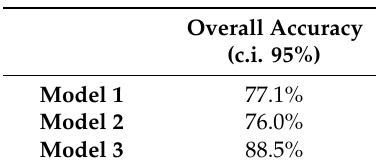
Table 4. Summary of accuracies obtained with each model.